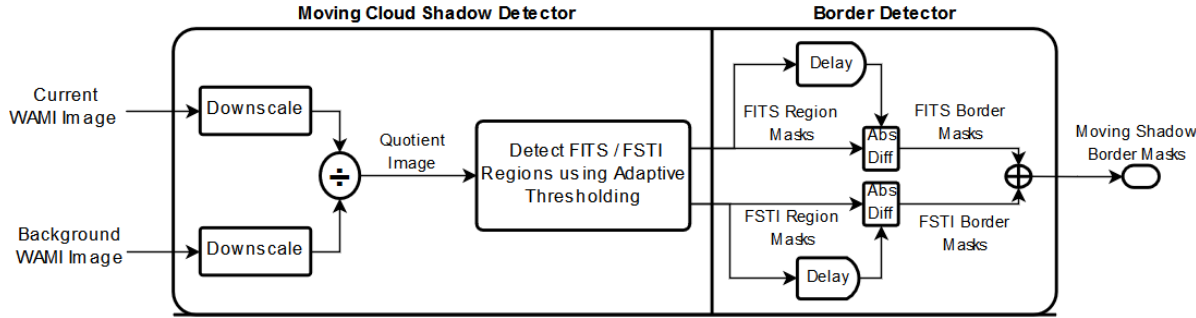
Figure 6. Moving Cloud Shadow Detector Flow Chart (FITS: First-well-illuminated-then-shadowed, FSTI: